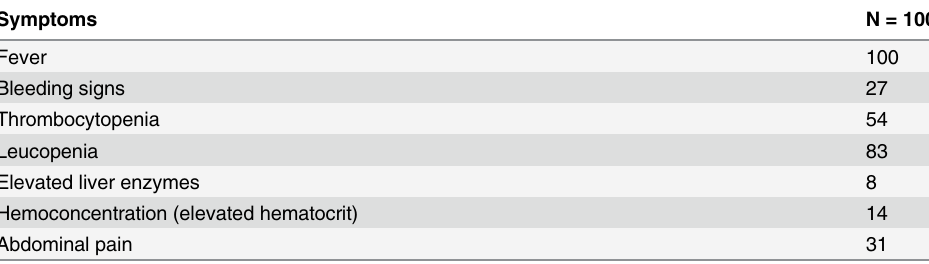
Table 4. Frequency of symptoms and biological parameters evoking dengue and recorded as clinical dengue episodes with a positive dengue